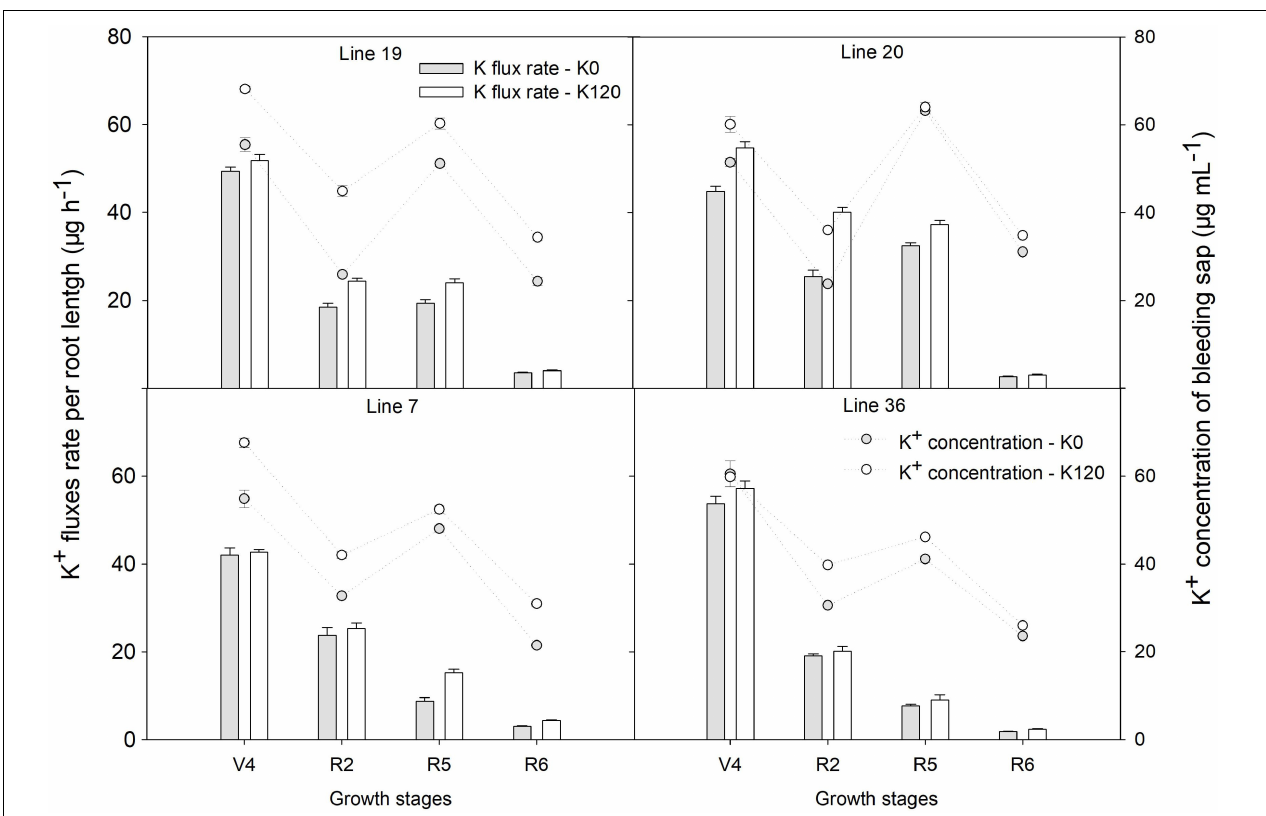
FIGURE 2 | K upward fluxes and concentration in root bleeding sap between two K efficiency genotypes in a pot experiment. Values are means of three replicates ± SE.